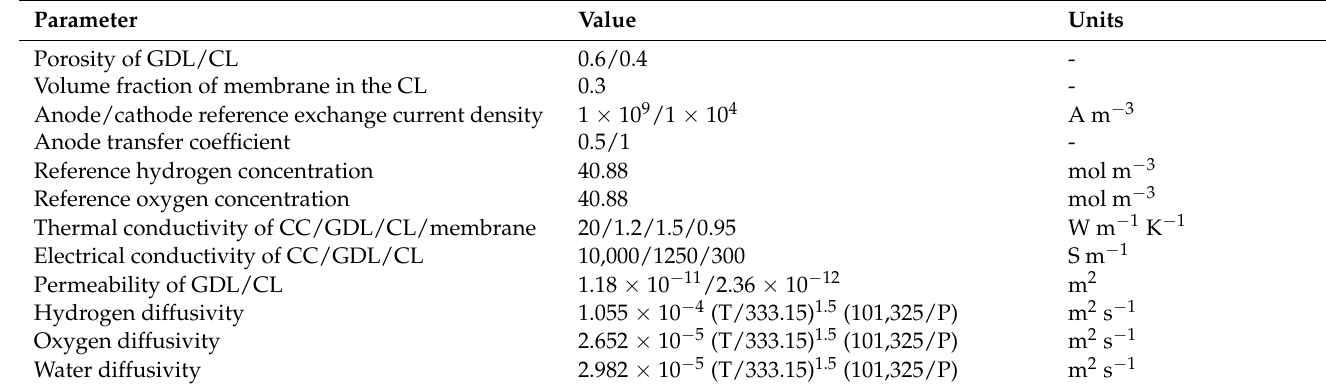
Table 3. Parameters used in the mathematical model.